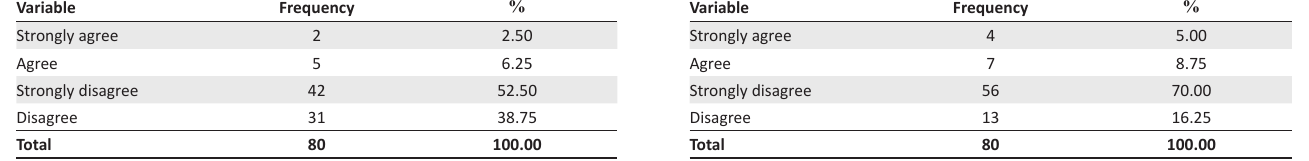
TABLE 4: Information in the performance development plans is relevant and assists in performance improvement. Variable